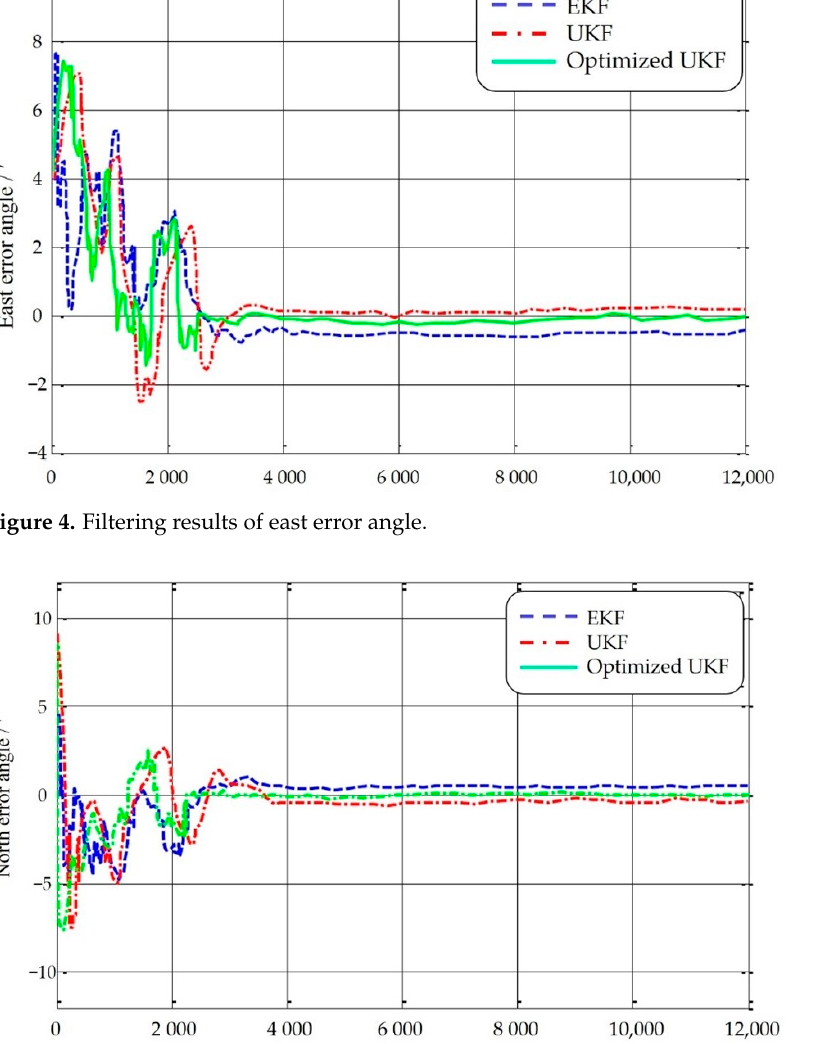
Figure 6. Filtering results of heading error angle. As can be discerned from Figures 4–6, the optimized UKF algorithm has higher ac- curacy than the EKF and UKF algorithms. The filtering errors of these three algorithms are shown in Table 1. Table 1. Filtering Results of error angle. φ E